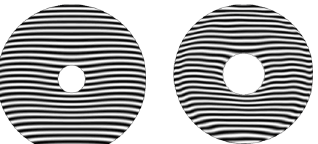
RMS SFE = 42.0 nm